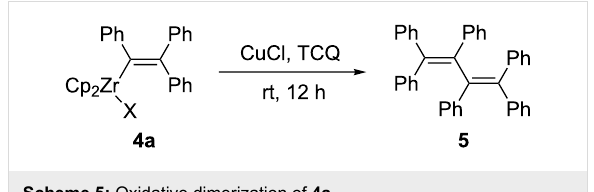
Scheme 5: Oxidative dimerization of 4a